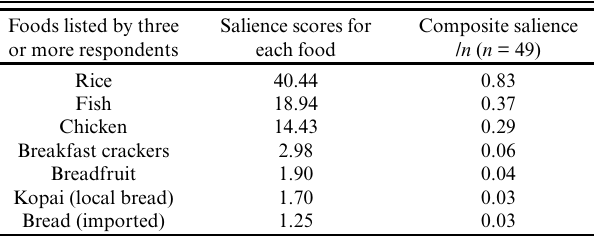
Table 5 . Freelisting results for food consumption (“What